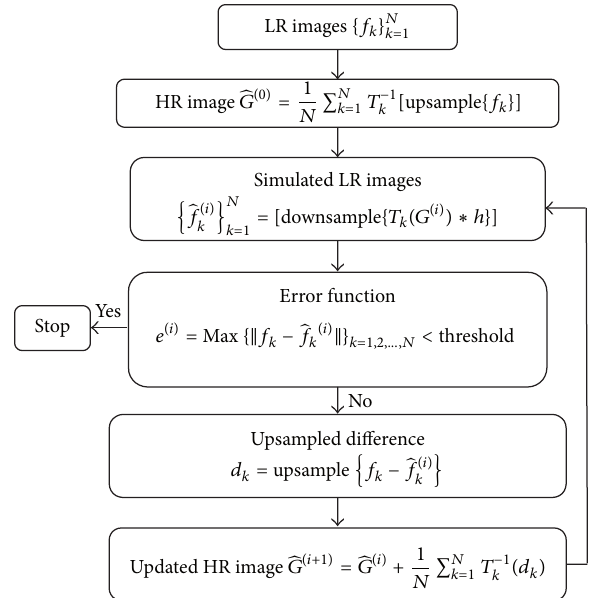
Figure 1: Block diagram of Irani and Peleg’s IBP